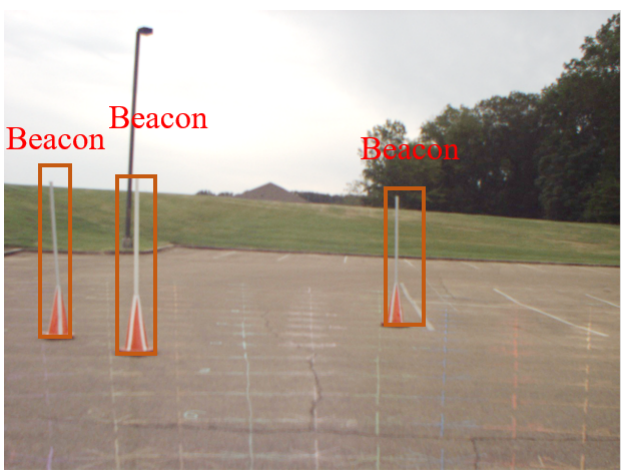
Figure 8. Camera detection example. Best viewed in